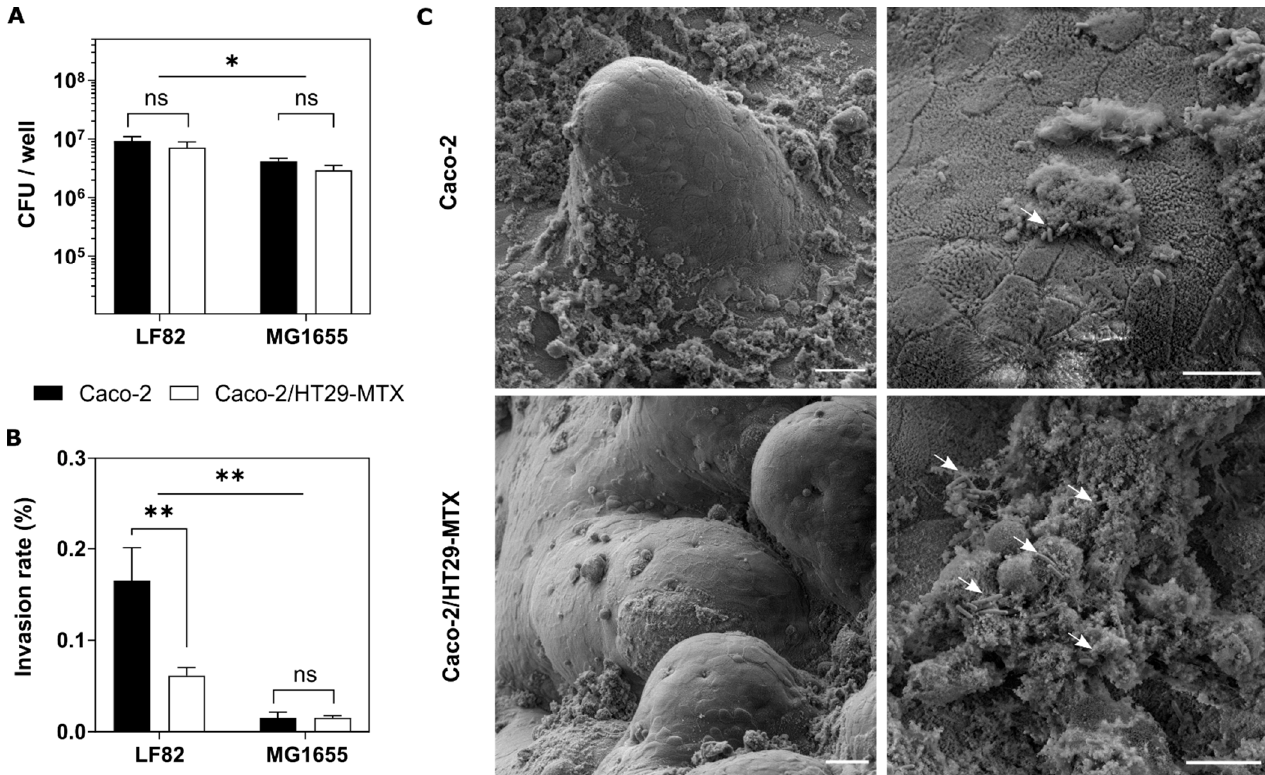
Figure 3. Adhesion and invasion assays. Quantification of adherent ( A ) or invaded ( B ) bacteria ( E. coli LF82 or MG1655 strains) to the 3D Caco-2 monoculture (black bars) or the 3D Caco-2/HT29-MTX co-culture (white bars) after 3 h of infection. The bacterial adhesion is expressed in CFU/well. The bacterial invasion is determined after 3 h of infection and subsequent incubation with gentamicin solution for 90 min. Invasion is expressed as the percentage of invaded E. coli relative to the adhered bacteria. Mean ± SEM of at least two independent experiments with 3 replicates, ns ( p > 0.05), * ( p < 0.05), ** ( p < 0.01). ( C ) Scanning electron microscopy (SEM) images of the 3D Caco-2 monoculture (upper panels) or the 3D Caco-2/HT29-MTX co-culture (lower panels) infected with E. coli LF82 for 3 h. White arrows indicate bacteria entrapped in the mucus. Scale bars = 25 μ m (left panels) and 10 μ m (right panels).